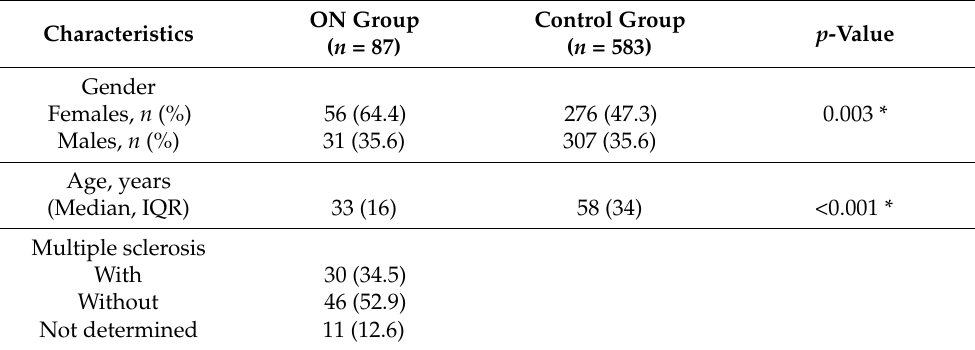
Table 1. Demographic characteristics of patients with optic neuritis (ON) and the control group subjects. Characteristics